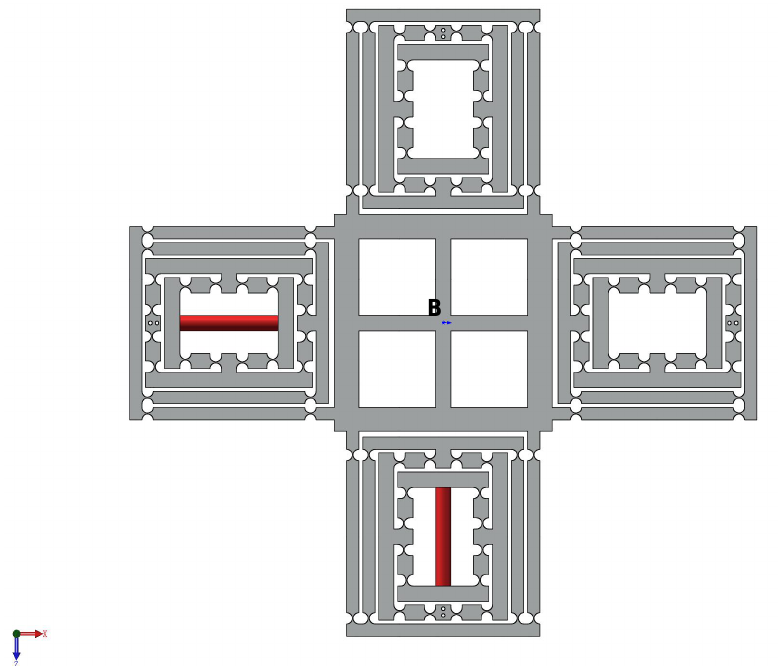
Figure 7. The new high precision decoupled XY compact parallel micromanipulator (the red part is